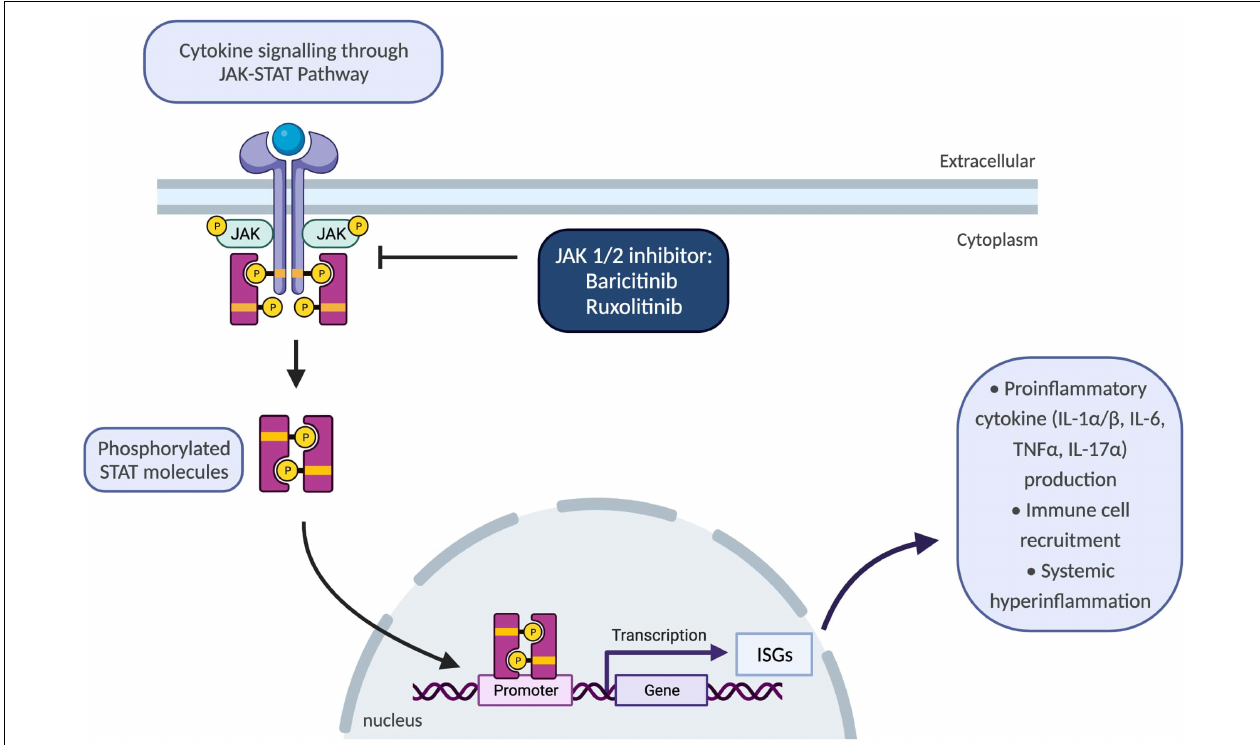
FIGURE 3 | Schematic showing JAK-STAT pathway and the use of JAK 1/2 inhibitors to block inflammatory responses. JAK/STAT pathway plays a key role for the downstream signalling of inflammatory cytokines encompassing interleukins and interferons. Upon binding of cytokines to their cognate receptors on cell surface, associated JAKs become activated and phosphorylate STAT proteins. Following phosphorylation, STATs translocate to the nucleus and regulate transcription of ISGs which drive activation of immune responses including proinflammatory cytokine production, differentiation, and proliferation of innate and adaptive immune cells, and consequently resulting in systemic hyperinflammation. IL-1 α / β , interleukin-1 alpha and beta; ISGs, interferon-signature genes; JAK, janus kinase; STAT, signal transducer and activator of transcription proteins; TNF α , tumour necrosis factor